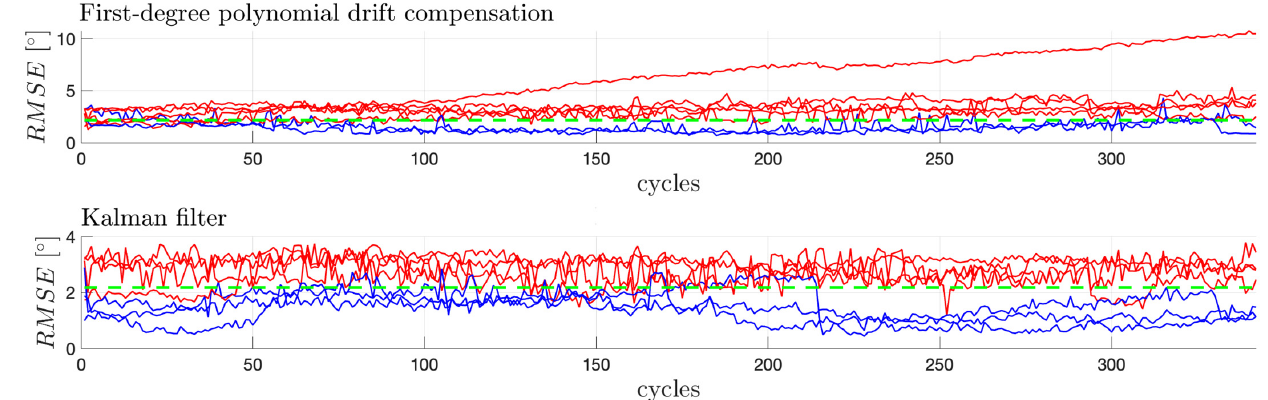
Figure 6. Knee joint angle root mean square error ( RMSE ) by crank cycle for all conducted 5 min measurements. The green dashed line represents the average entire trial RMSE of the Kalman filter calculated across all cycles and all subjects. The red lines represent measurements for which the average RMSE per cycle exceeds the average RMSE of the Kalman filter.